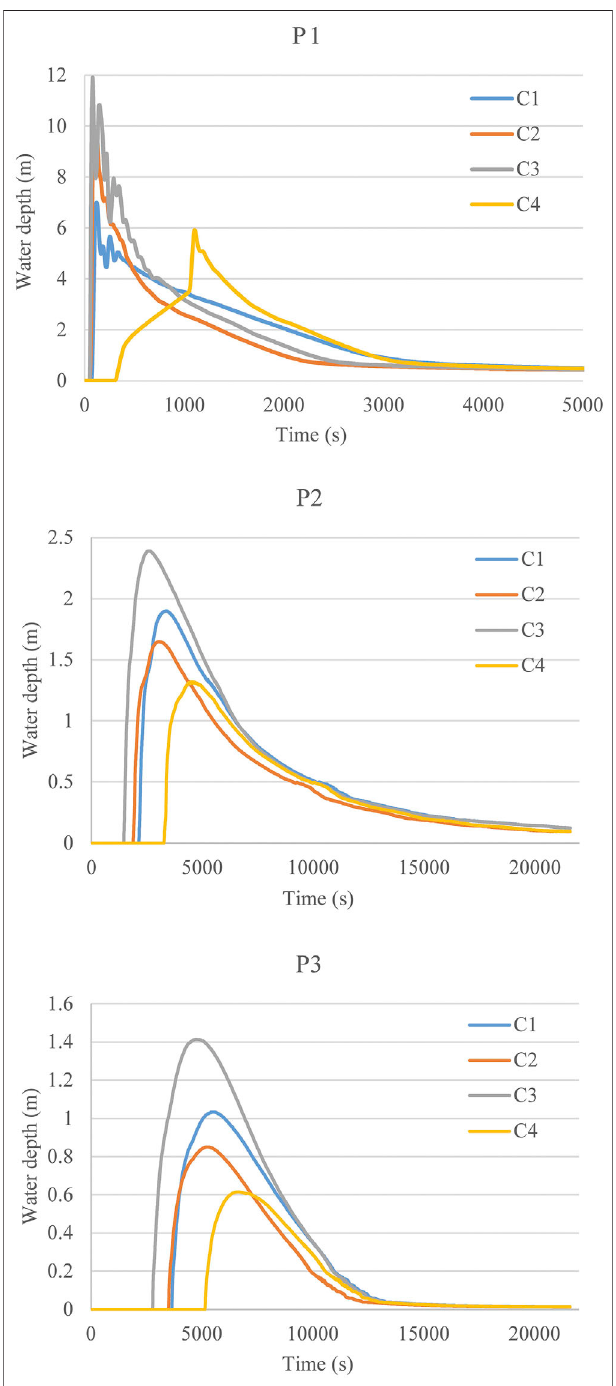
FIGURE 5 | Depth – time graphs at P1, P2, and P3 under condition C1 – C4.